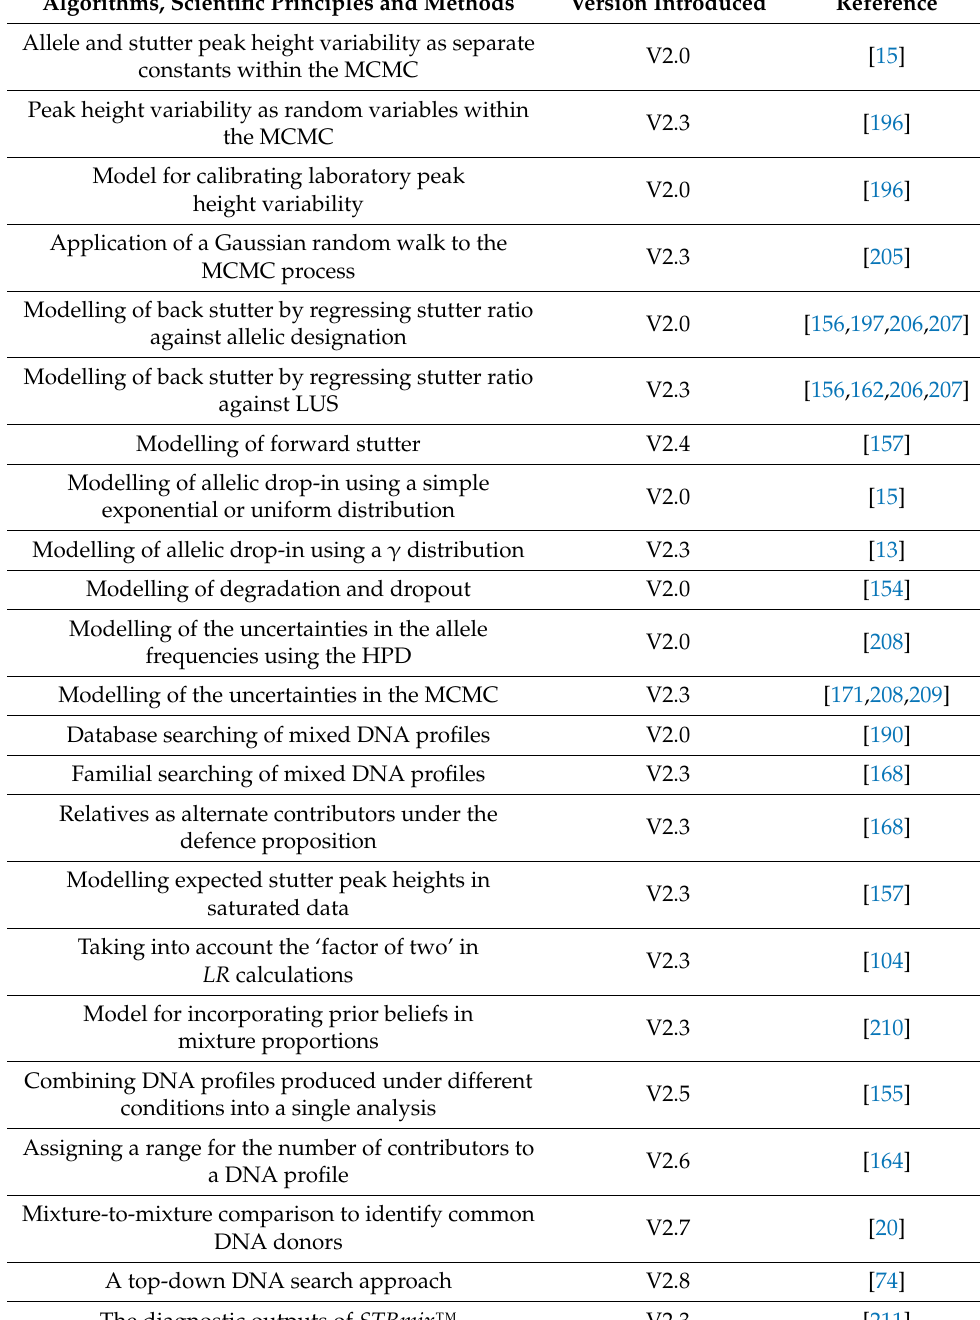
Table 1. Publications of conceptual components of STRmix ™